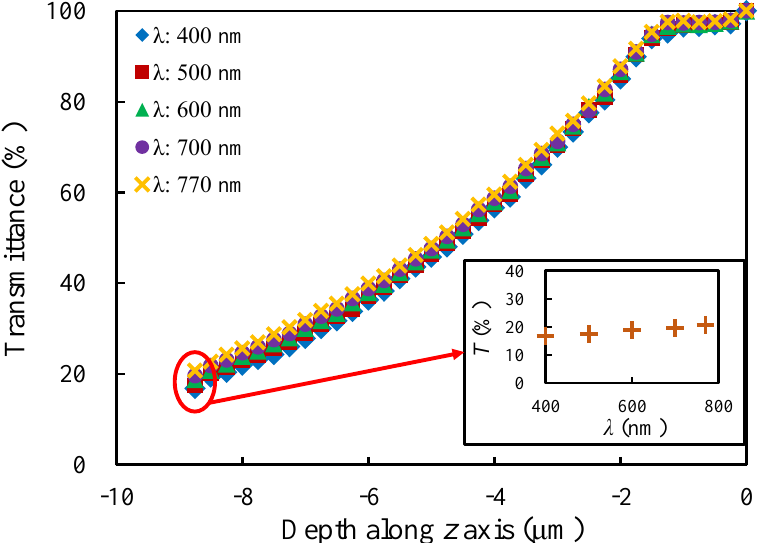
Figure 15. Evolution of the transmittance with the depth along z axis for the models under different wavelengths of